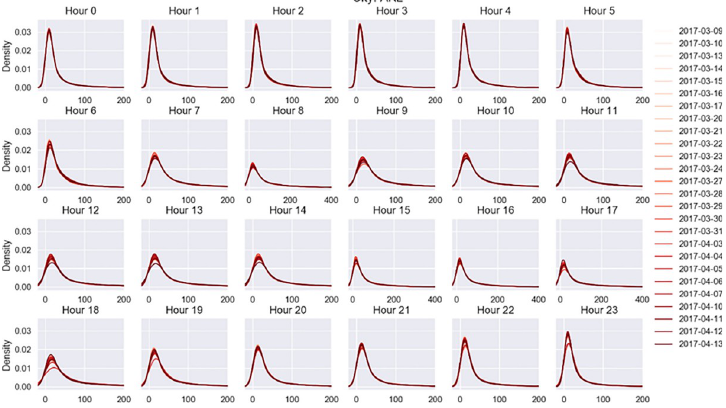
Fig 8. Stability of network equilibrium. Kernel density plot at every one hour for Auckland city that has the least overlap probability.